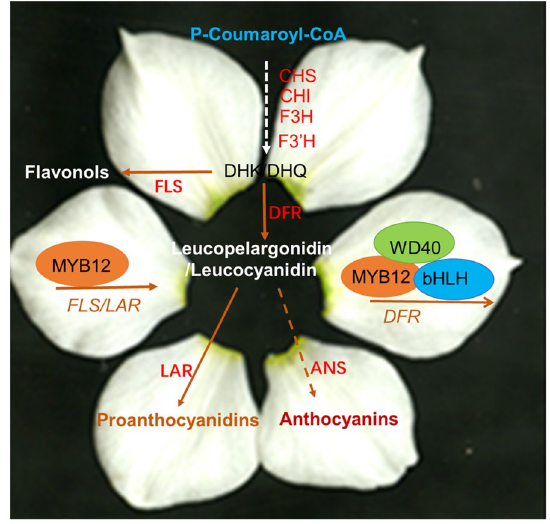
Fig. 8 A working model for NtMYB12 or MBW determine flavonol or (pro)anthocyanin biosynthesis of narcissus petal. NtMYB12 dually functions on flavonol and proanthocyanin biogenesis via physically binding to NtFLS and NtLAR promoter activating their expression and on (pro)anthocyanin biosynthesis via NtMYB12-NtWD40-NtbHLH (MBW) triplex activating NtDFR and NtANS expression. Requirement of MBW complex for the competition between flavonol and anthocyanin biosynthesis results in narcissus colorized petal